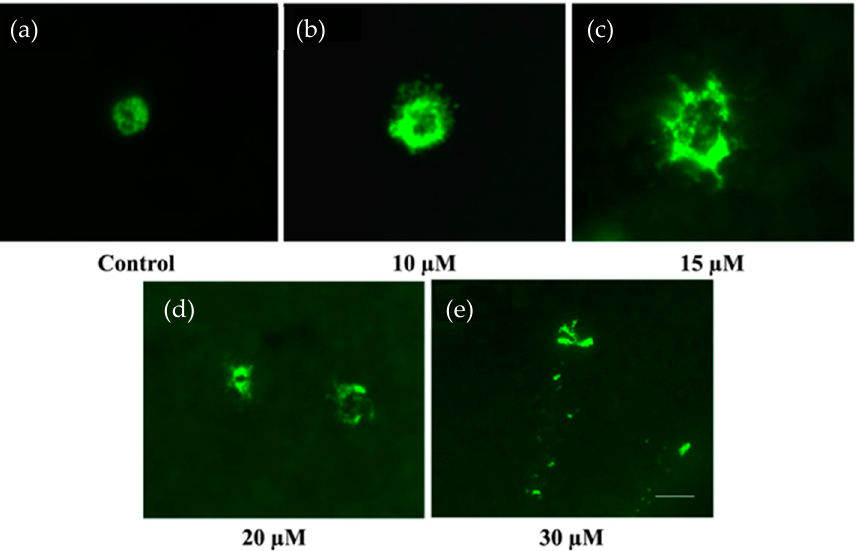
Figure 2. Representative epifluorescence micrographs showing the cochlear MCs in the LW after 24 h of exposure to 10 µ M, 15 µ M, 20 µ M, and 30 µ M cisplatin. The MCs were labeled with avidin–Alexa Fluor ™ 488. ( a ) Cochlear MC after incubation in the culture medium only (control). ( b ) Cochlear MC after exposure to 10 µ M cisplatin. ( c ) Cochlear MC after exposure to 15 µ M cisplatin. ( d ) Cochlear MC after exposure to 20 µ M cisplatin. ( e ) Cochlear MC after exposure to 30 µ M cisplatin. The scale bar represents 10 µm.